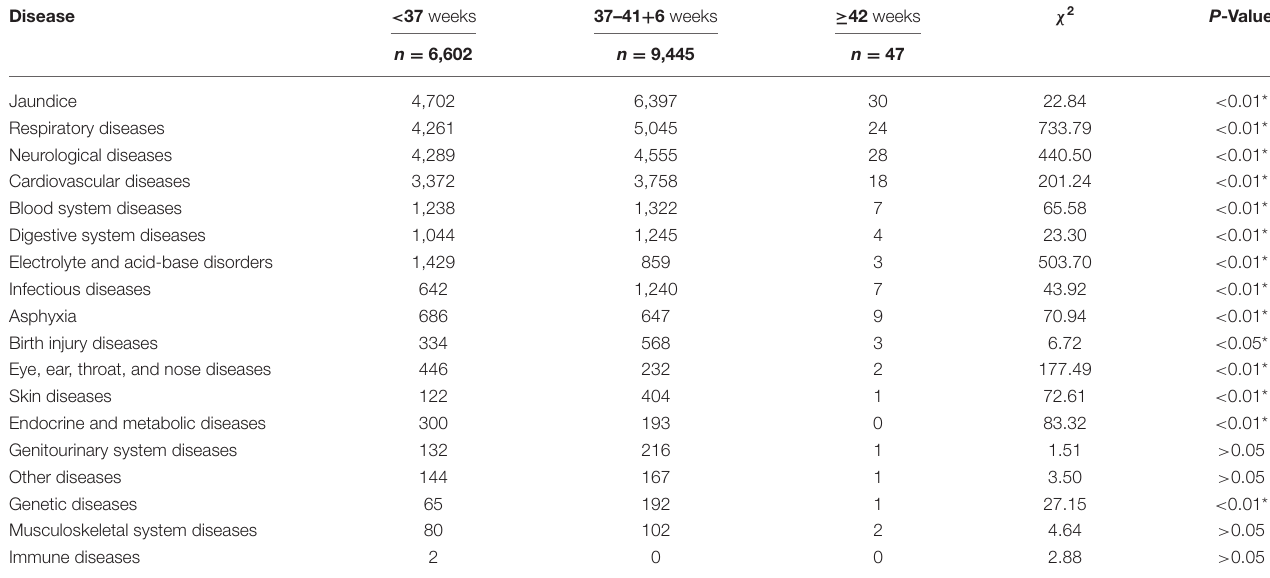
TABLE 9 | Prevalence of neonatal diseases in relation to gestational age. Disease